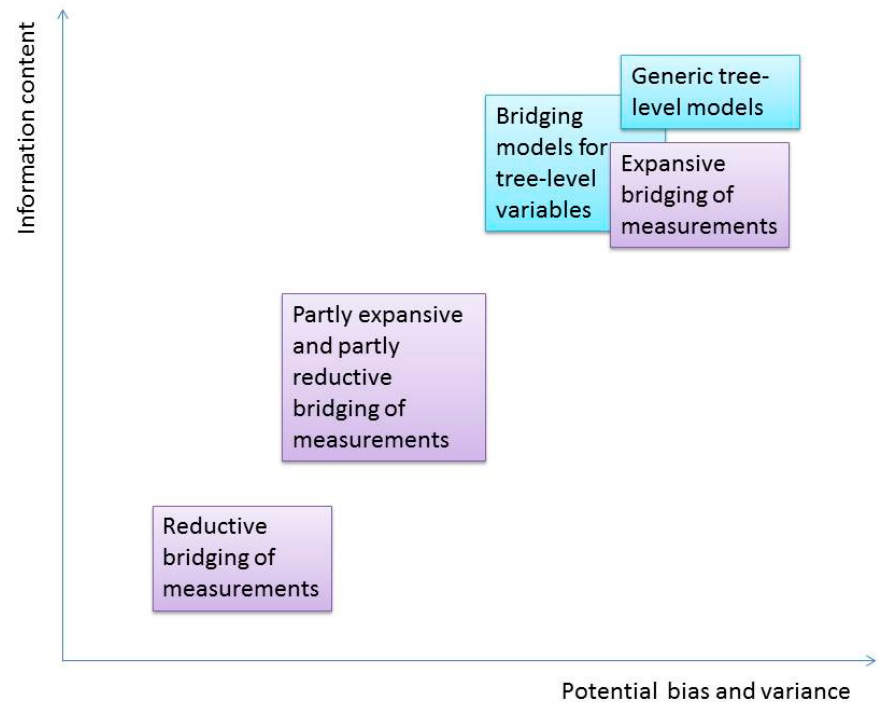
Figure 2. Relation between information the content and harmonization efforts.